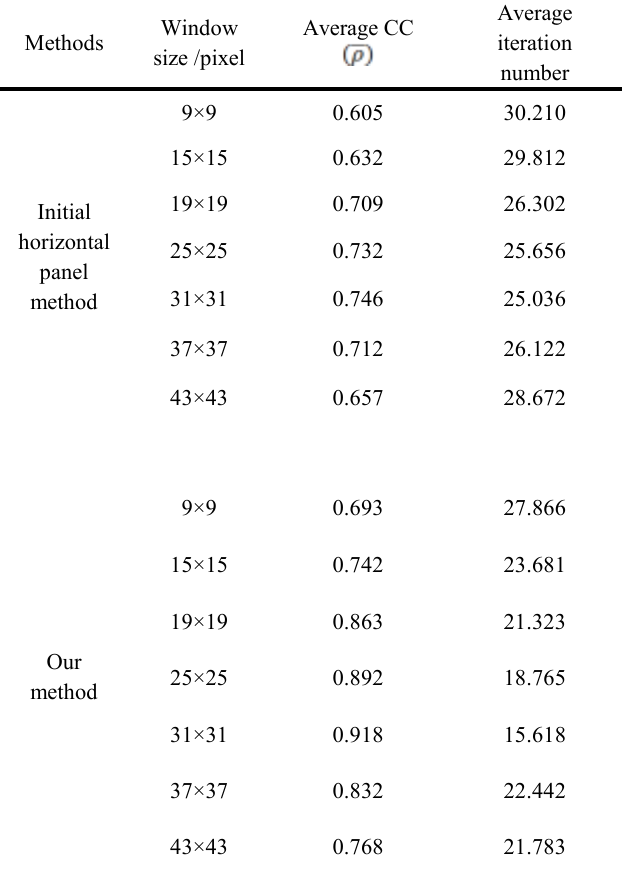
Table2. The effect of window size on matching results